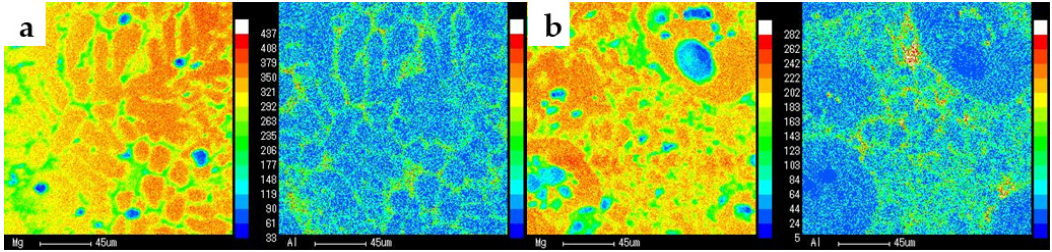
Figure 12. Results from EPMA area analysis of AM60 sample under ( a ) liquid diecasting and ( b ) SIRD.